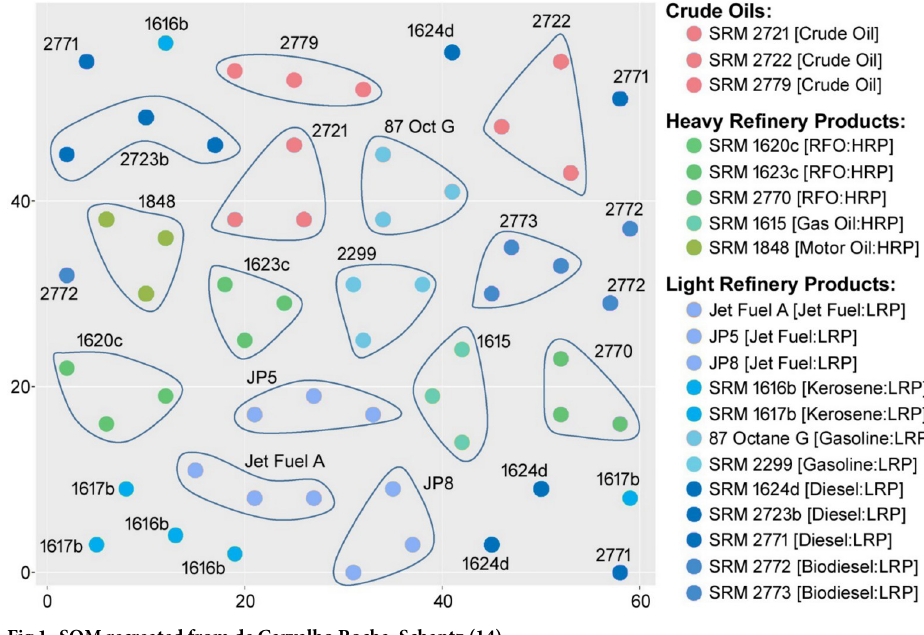
Fig 1. SOM recreated from de Carvalho Rocha, Schantz